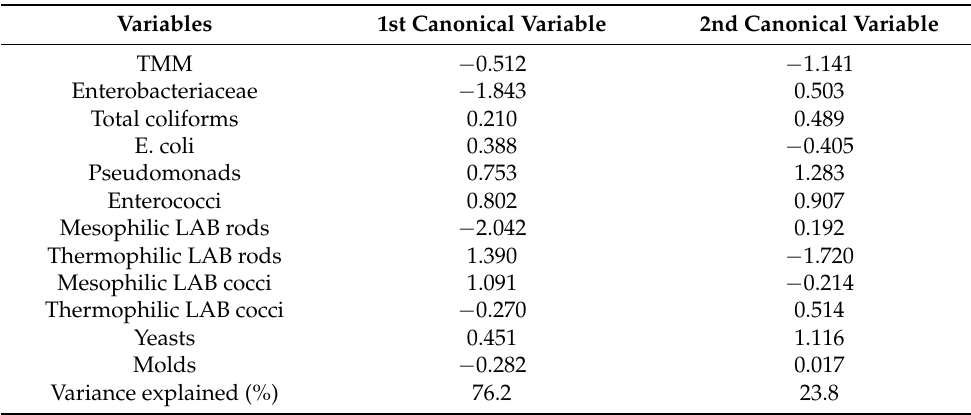
Table 2. Standardized canonical discriminant function coefficients.